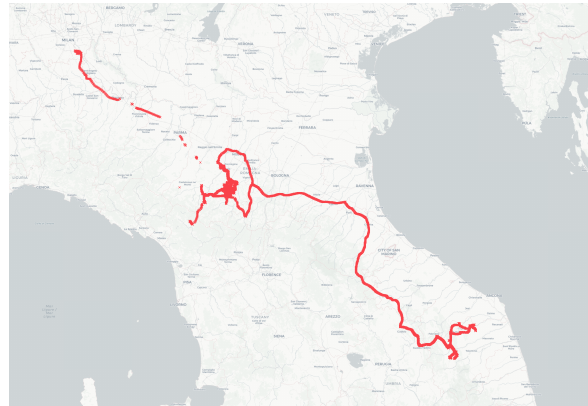
Figure 4. A plot of one of the two main areas of the STAGA GPS samples. Most data points of the dataset were projected onto